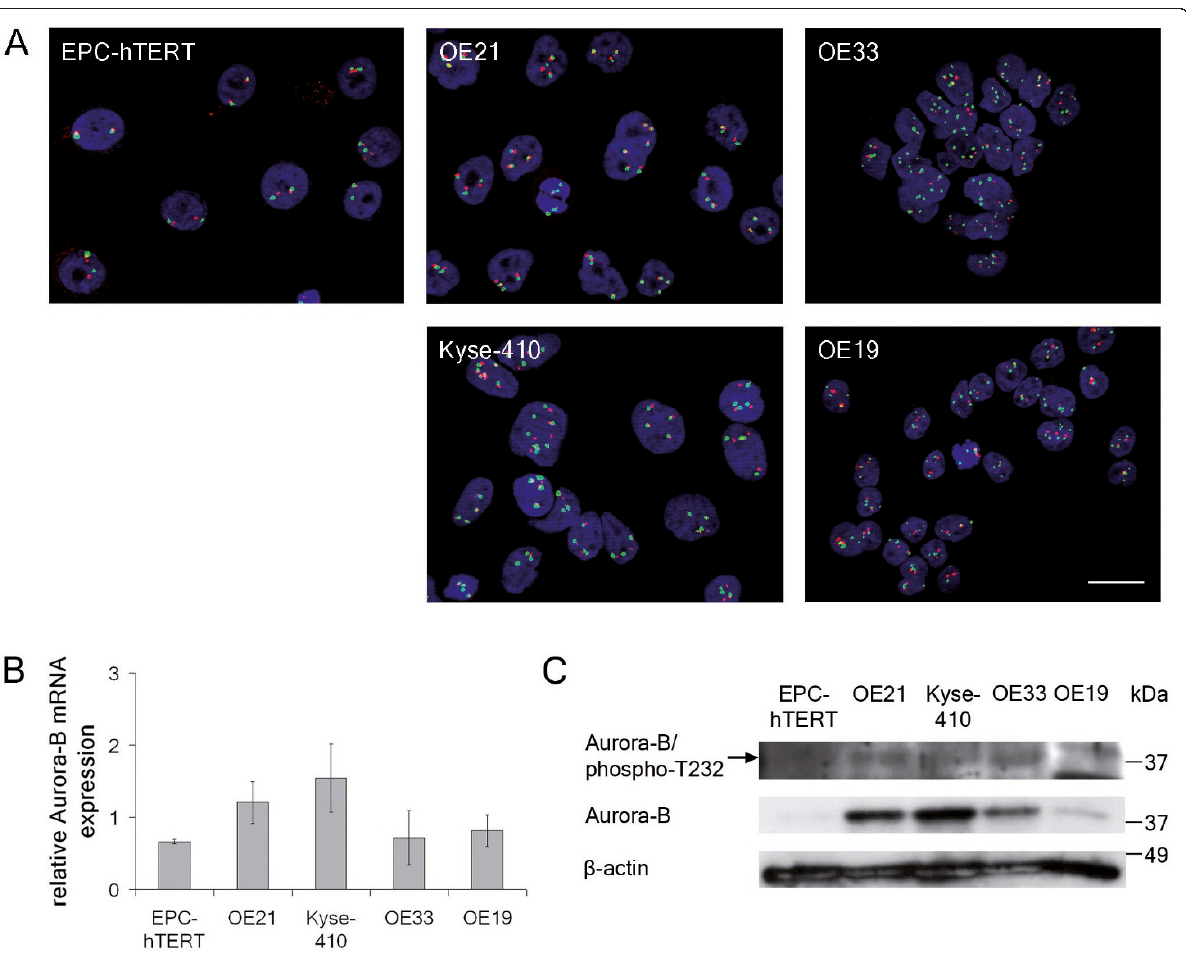
Figure 3 Aurora-B gene copy numbers, mRNA and protein expression in normal esophageal epithelial cells and esophageal cancer cells . A . FISH analysis of AURKB (red signals) and Chromosome 17 (CEP17; green signals). Bar = 20 μ m, all panels are in the same magnification. B . Relative Aurora-B mRNA expression was determined by qRT-PCR (mean ± standard deviation of three independent experiments). C . Photograph of Aurora-B/phospho-T232 and Aurora-B protein expression by immunoblot analysis, representative for 3 independent experiments. b -Actin served as laoding